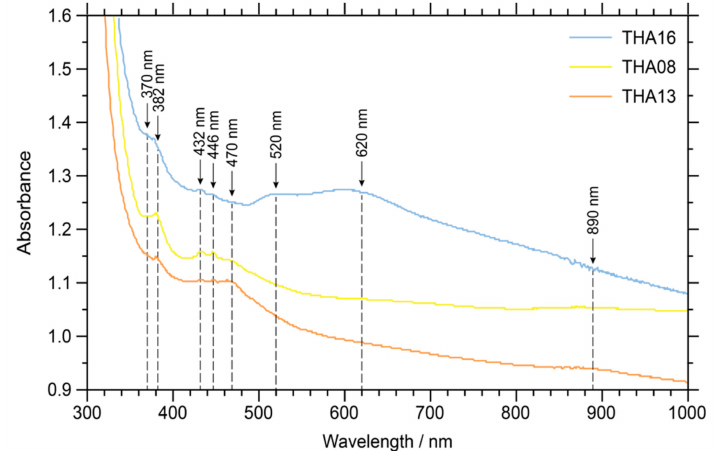
Figure 14. UV near-infrared spectra of kyanite of various colors. Spectra are shifted and re-scaled vertically for clarity. Absorbance values are those of sample